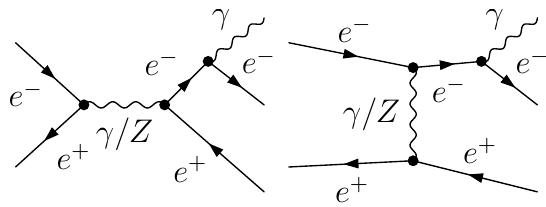
Figure 5 . Tree level diagrams for the e + e (cid:0) ! e + e (cid:0) (cid:13) processes in